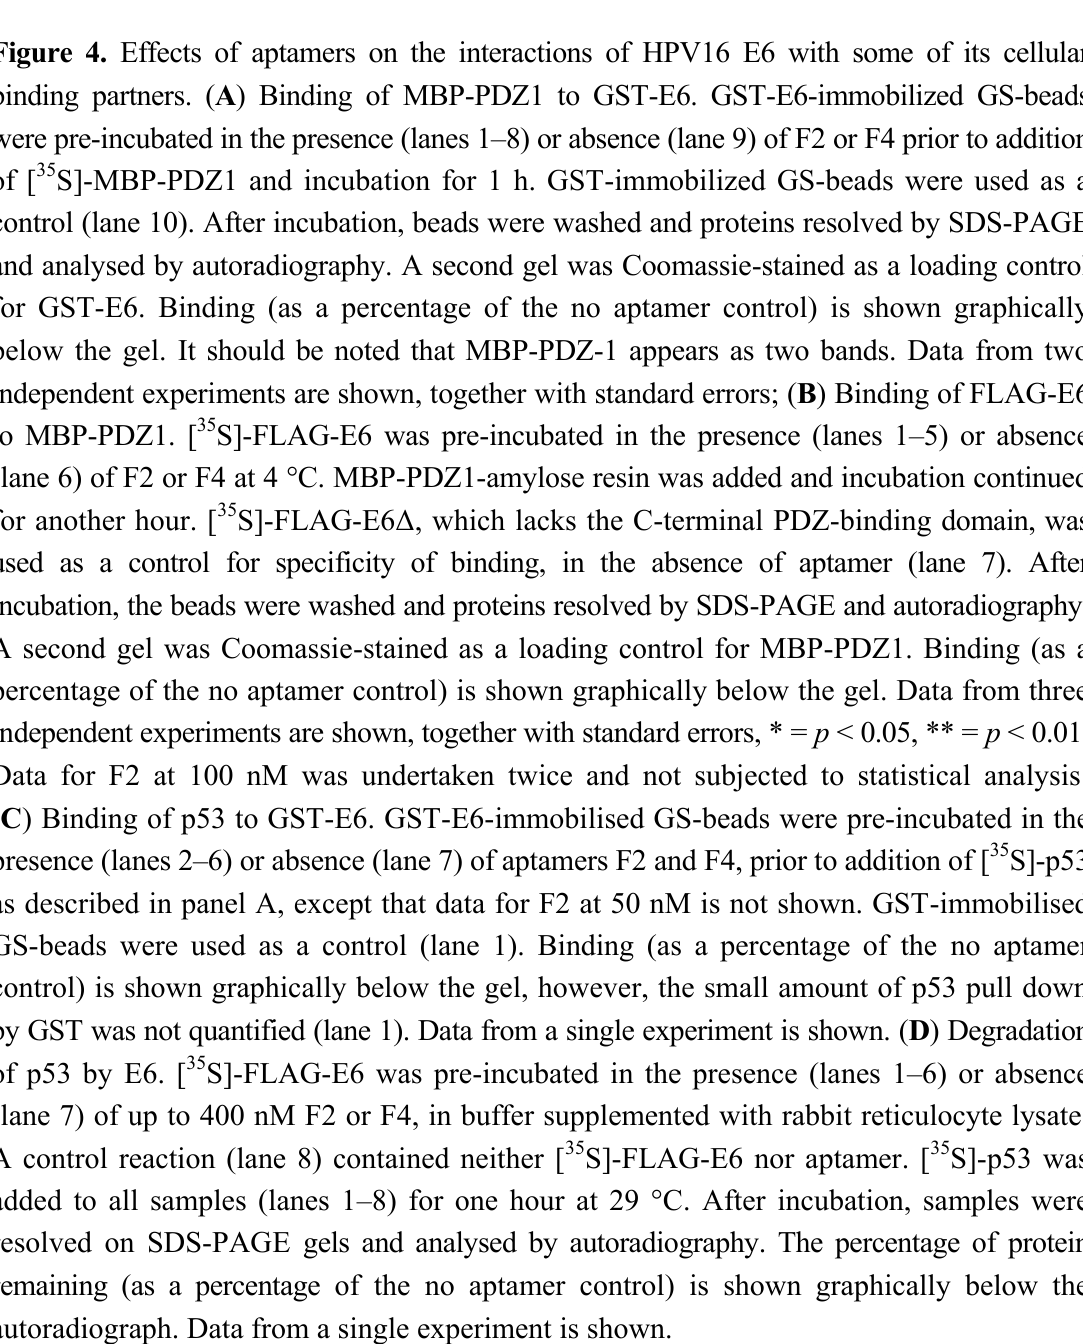
Figure 4. Effects of aptamers on the interactions of HPV16 E6 with some of its cellular binding partners. ( A ) Binding of MBP-PDZ1 to GST-E6. GST-E6-immobilized